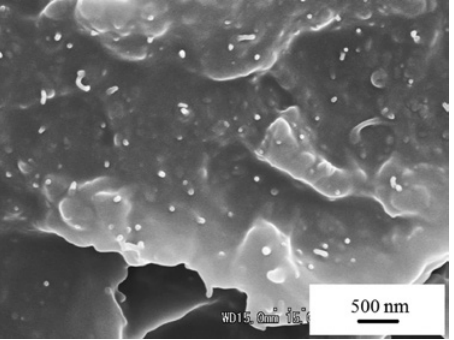
Figure 12: SEM micrograph of the core layer of the 5 wt.% MWCNT/ PC composite obtained at the injection temperature of 280 ° C and injection speed of 10